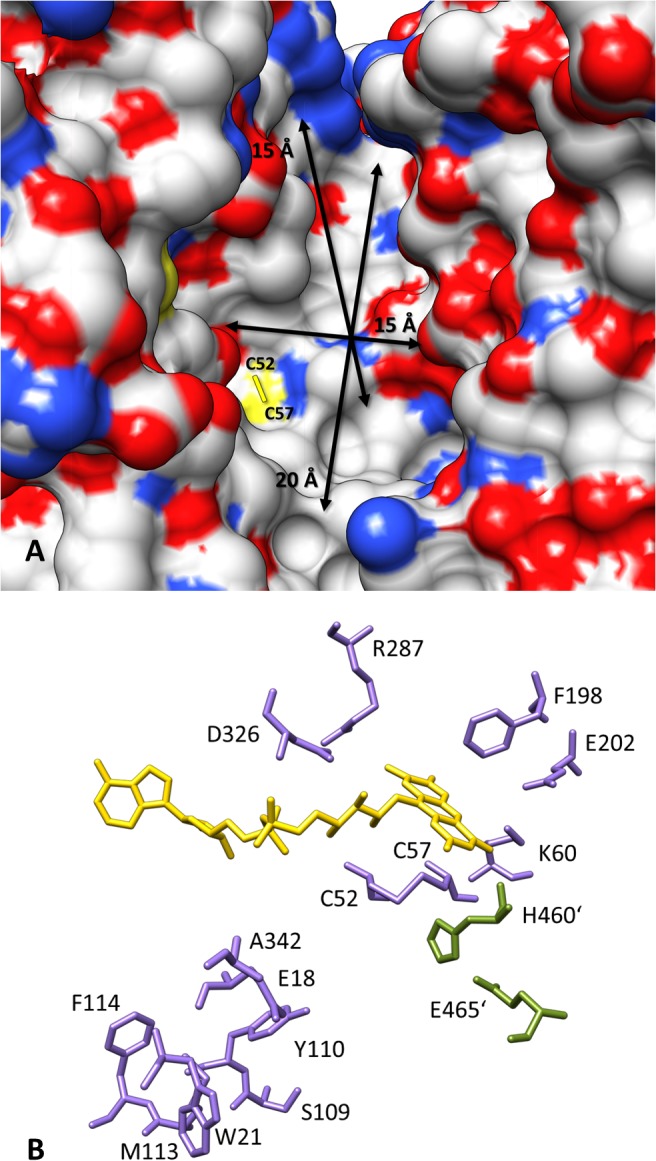
Schematic presentation of the active site of T. cruzi TR.(A) Top view into the large trypanothione disulfide binding site having a dimension of about 15 x 15 x 20 Å (arrows). The disulfide bridge formed by C52 and C57 in the oxidized form of the enzyme is indicated. The cofactor FAD is not visible because it is buried within the structure. On the solvent accessible surface nitrogen is indicated as blue, oxygen as red and sulfur in yellow. (B) The isoalloxazine ring of FAD (yellow) forms the center of the active site. NADPH binds at the re-site, while TS2 binds at the si-site of the flavin ring where also the redox active dithiol/disulfide couple of Cys52-Cys57 is located. Glu18 (Ala34 in human GR), Trp21 (Arg37), Ser109 (Ile113), Met113 (Asn117) and Ala342 (Arg347) are the five residues in the active site that are not conserved when comparing TR with human GR. Primed residues (green) are provided by the second subunit of the homodimeric protein. The substitution of Ala34 and Arg37 into Glu and Trp, respectively, converts human GR in an enzyme with TR activity and vice versa.